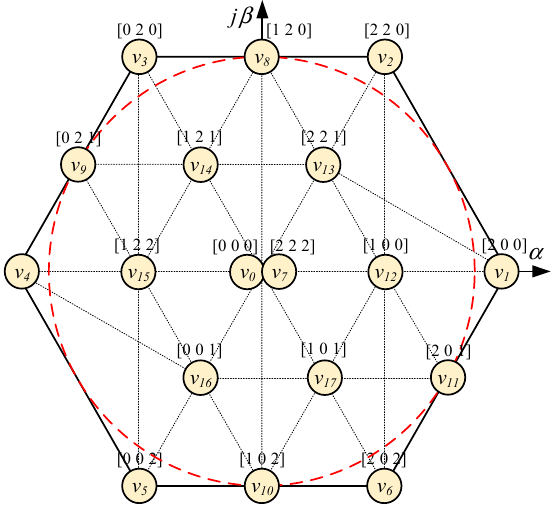
Figure 3. Space vector diagram of asymmetric T − type 3 − level NPC inverter. The specific characteristics of an asymmetric inverter compared with conventional 2- level and 3-level inverters are reported in Table 3. The asymmetric topology can generate 𝑉 ±𝑉 line voltages at 5 voltage levels 0, ± (cid:3117) (cid:3031)(cid:3030) , and (cid:3031)(cid:3030) similarly to the traditional 3-level in- (cid:3118)